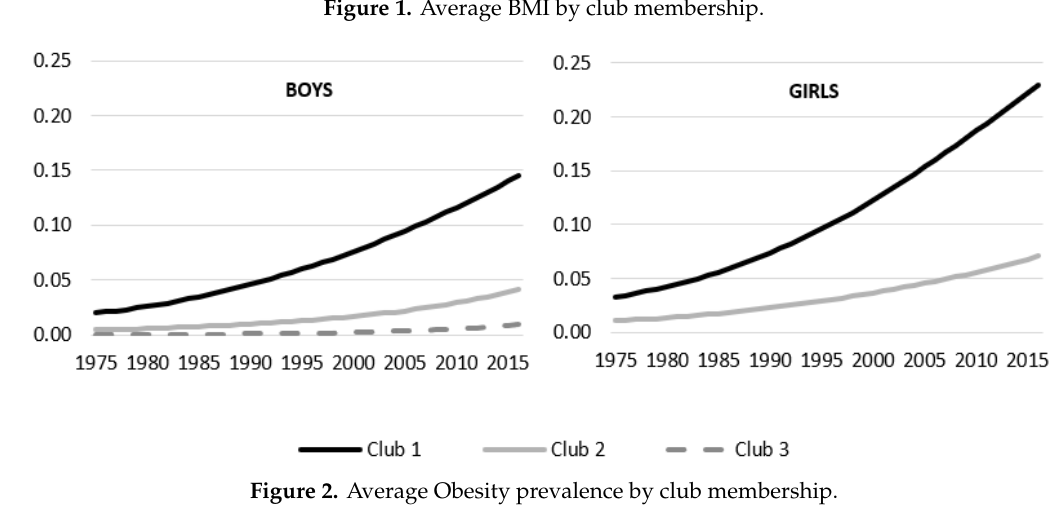
Figure 2. Average Obesity prevalence by club membership. Table 3. Mean values of descriptive variables by Cluster. Body Mass Index